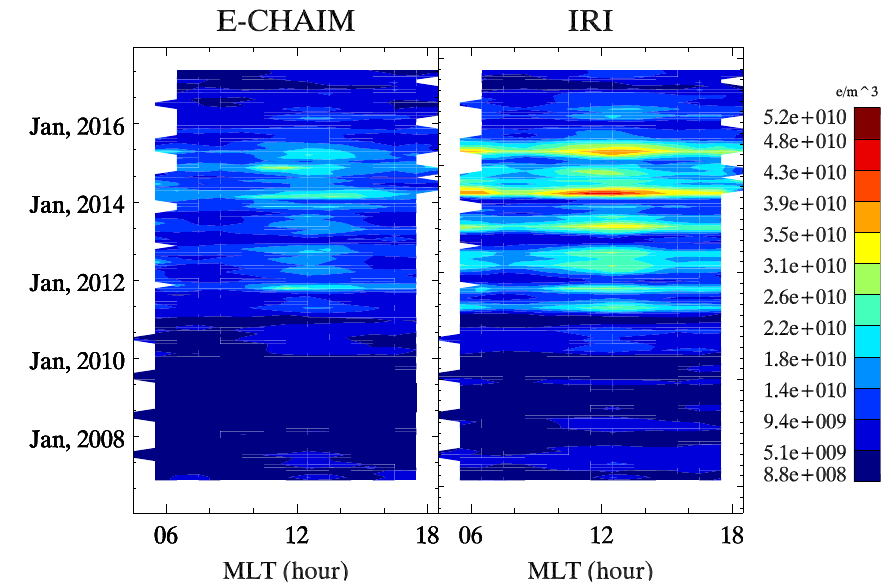
Fig. 10. Monthly RMS errors for E-CHAIM (left) and the IRI (right) for satellite